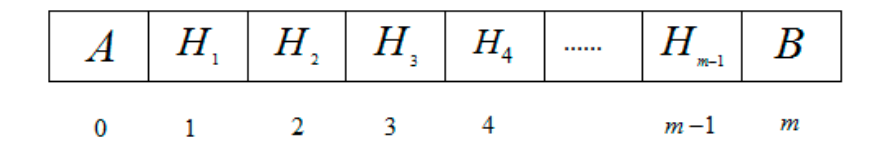
Figure 3. Fixed-length real-valued gene.